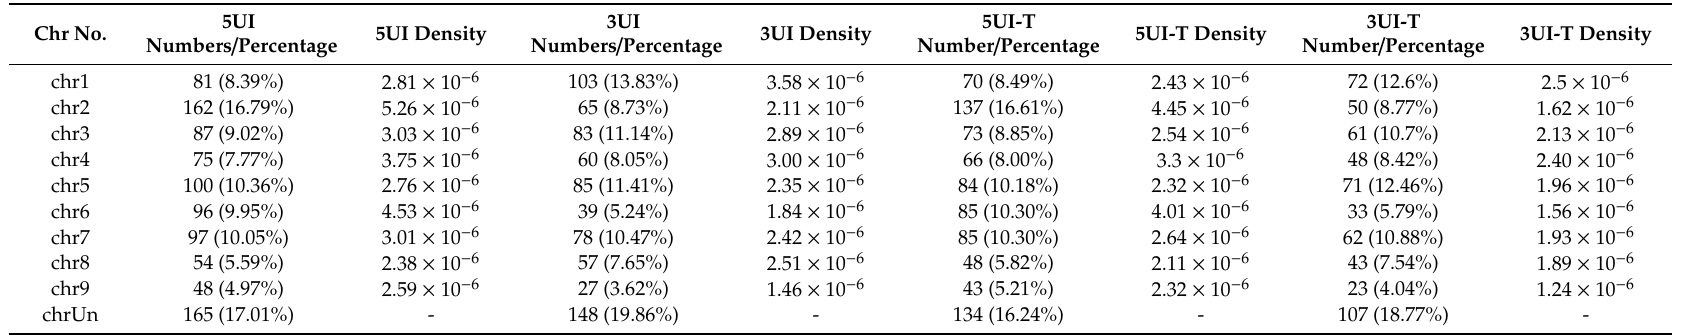
Table 3. Statistics information of the distribution of UTR introns (UIs) and transcripts containing UI (UI-Ts) in the Citrus sinensis chromosomes. 5UI-T represents gene transcript containing 5UI; 3UI-T represents gene transcript containing 3UI. Chr: chromosome. Chr